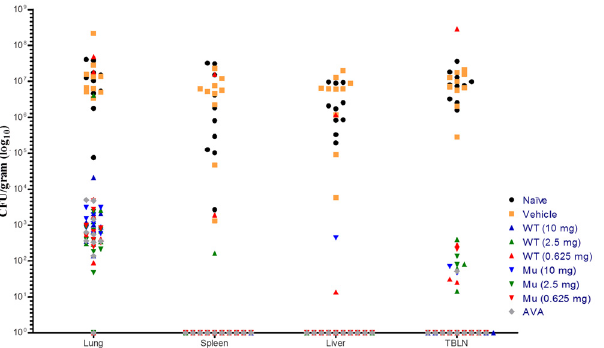
Fig 4. Recovery of B . anthracis from Select Tissues of vaccinated, unvaccinated control, and sham vaccinated control rabbits.